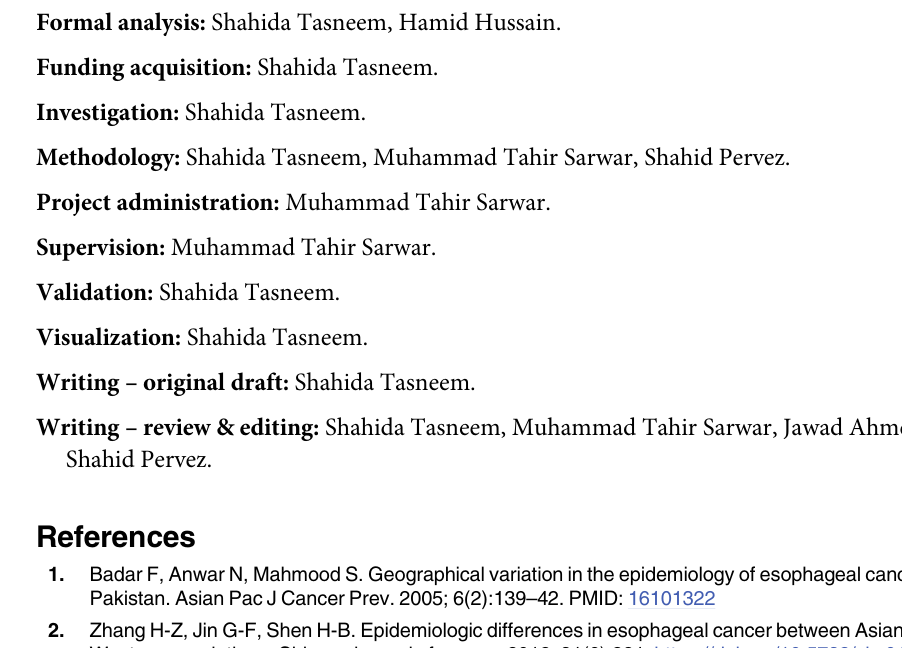
S1 Table. SPSS data spread sheet for IHC expression of